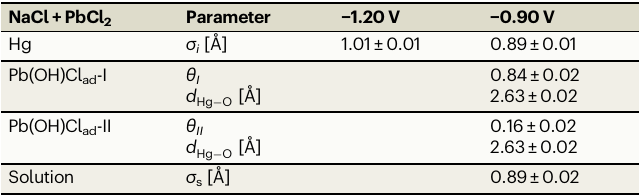
Table 2 | Structural data on the precursor adlayer formed in Cl-containing solution NaCl+PbCl